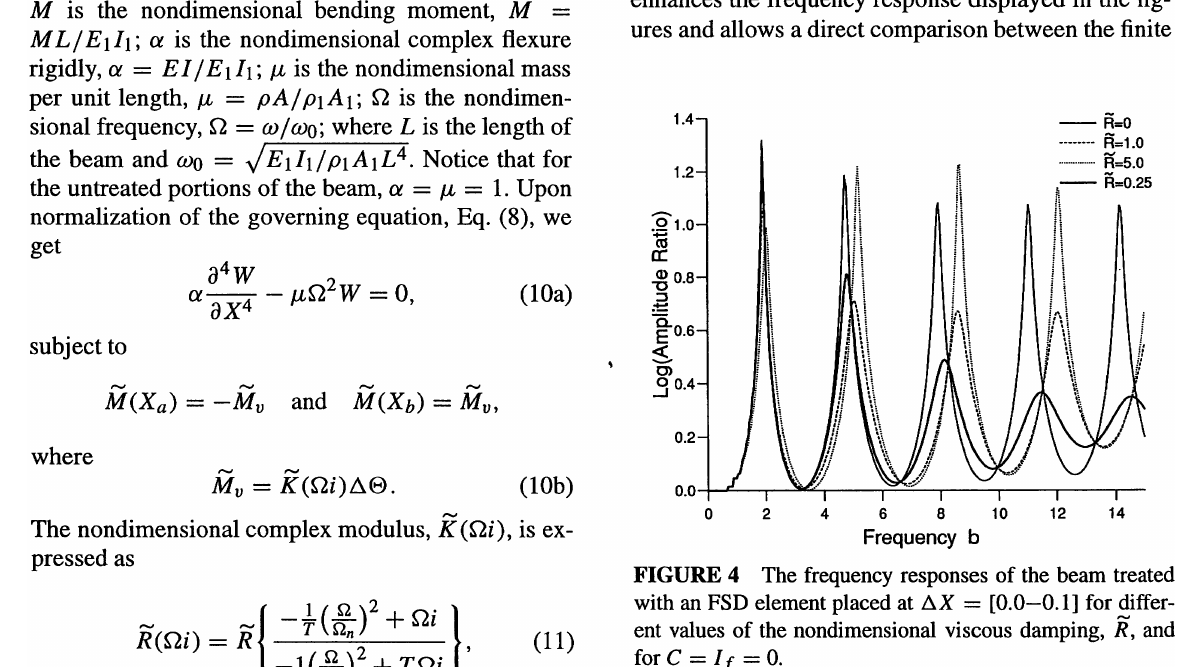
FIGURE 4 The frequency responses of the beam treated with an FSD element placed at t:J.X = [0.0-0.1] for differ ent values of the nondimensional viscous damping, ii, and fore = If =